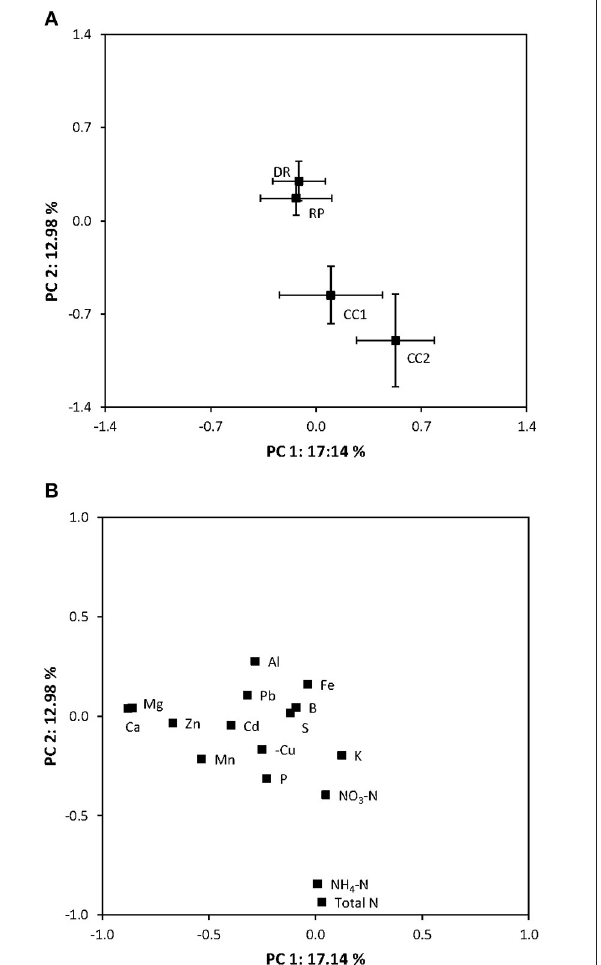
FIGURE 5 | Principal component analysis showing (A) soil nutrient availability based on the concentration of anions and cations adsorbed onto PRS-probes in the dispersed-retention (DR) treatment, the retention patch (RP), in the clear-cut treatment (CC, 9m, or more from the retention patch) and in the clear-cut edge treatment (CCE, within 9m of the retention patch). (B) Relative contributions of individual ions to differences in nutrient availability. Horizontal and vertical error bars represent standard